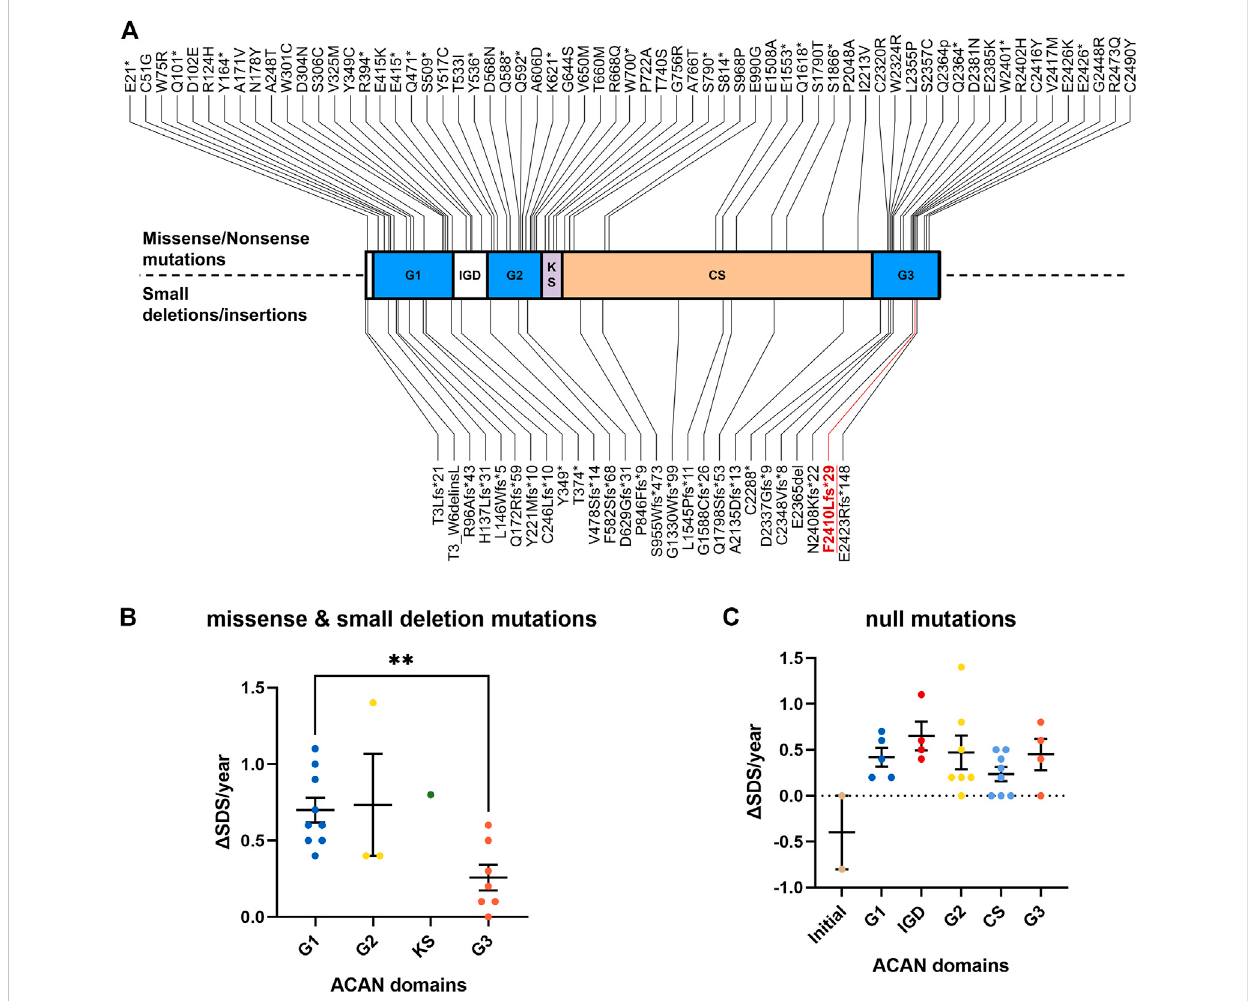
FIGURE 2 OverviewofallknownACANmutations. (A) Theredfontsymbolizesthemutationidenti fi edinthisstudy. (B) TheincreasingSDSforeachyear( Δ SDS/ year)ofpatientswithACANmissenseandsmalldeletionmutationsduringGHtreatment. (C) TheincreasingSDSforeachyear( Δ SDS/year)ofpatientswith ACAN null mutations during GH treatment. G1, globular domain 1; IGD, interglobular domain; G2, globular domain 2; KS, keratin sulfate attachment domain; CS, chondroitin sulfate attachment domain; G3, globular domain 3; SDS, standard deviation scores. **p <